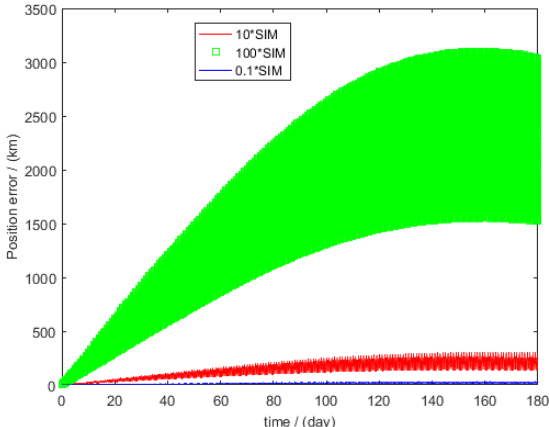
Figure 2. Effects of surface-mass ratio changes on ORB-1 forecast error